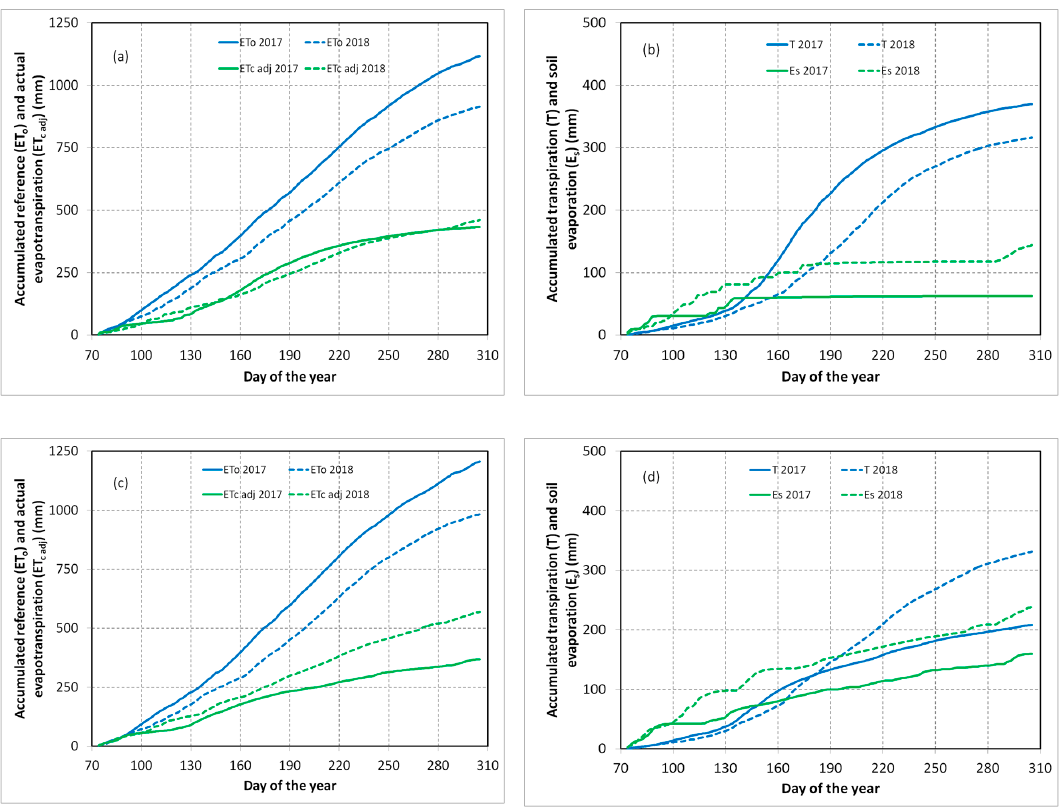
Figure 3. Accumulated reference (ET o ), actual evapotranspiration (ET c adj ), transpiration (T) and soil evaporation (E s ) at case study I ( a , b ), and at case study II ( c , d ), estimated by the SIMDualKc model for the vegetative cycles of 2017 and 2018.